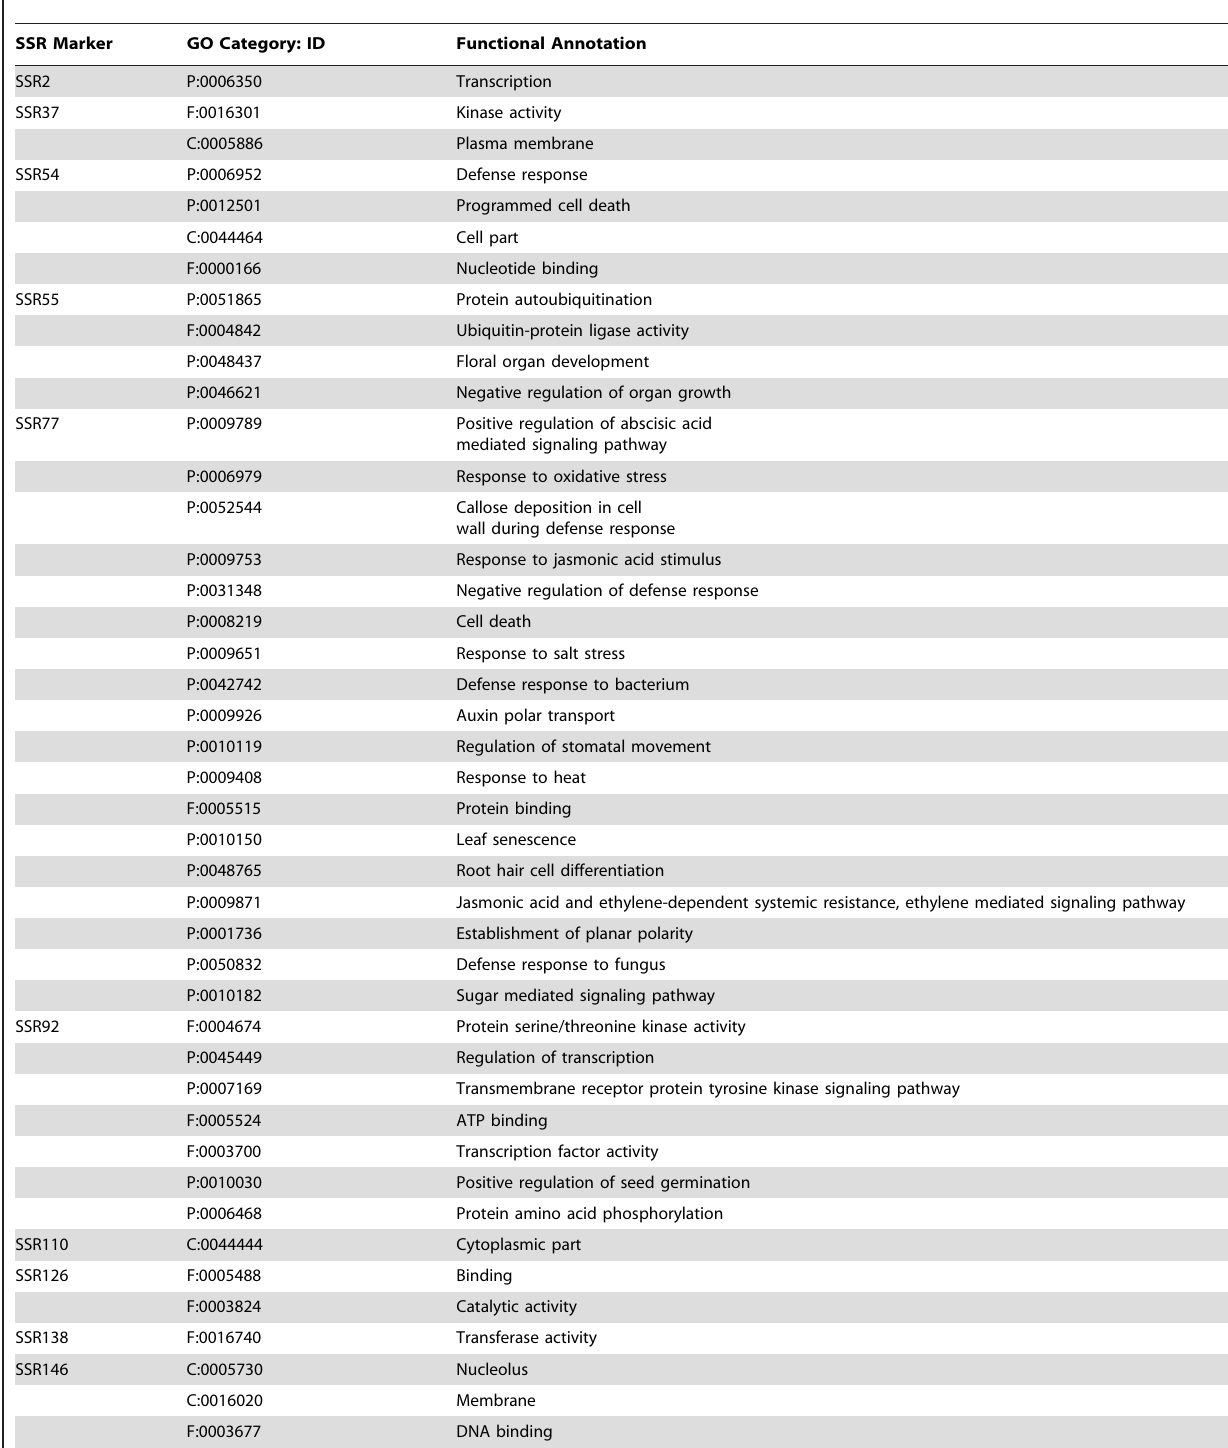
Gene ontology (GO) functional Categories: C =Cellular component, F =Molecular function, P =Biological process.